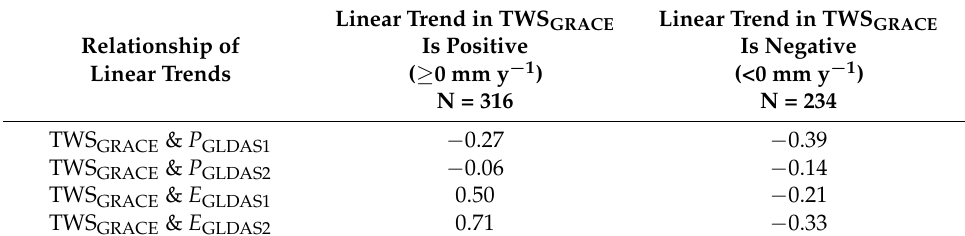
Table 2. Spatial correlation coefficients of the regional linear trends between TWS GRACE and P or E . N denotes sample number.